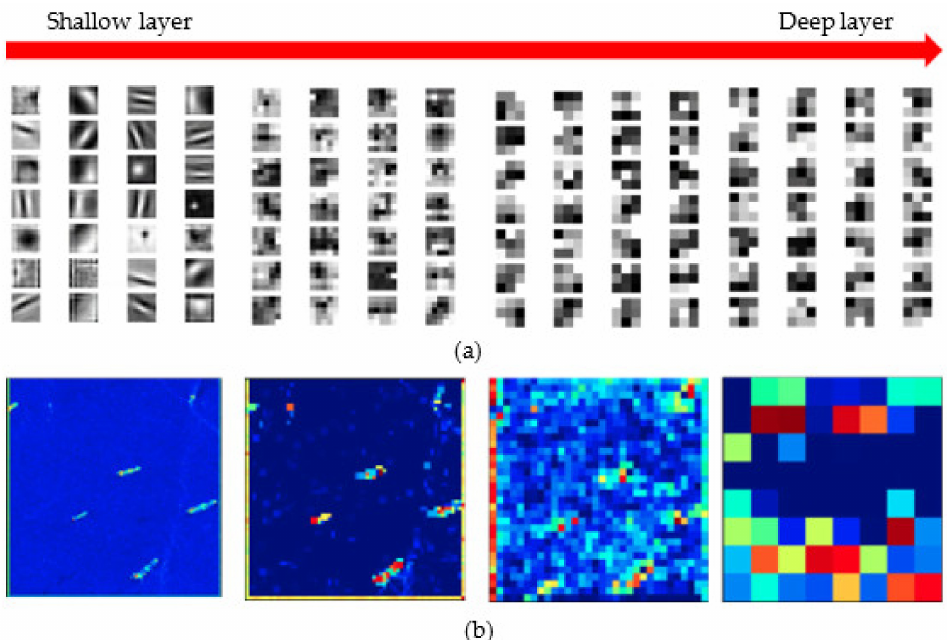
Figure 3. The visualization of feature maps of SAR images. ( a ) The visualization of feature maps extracted by filters from the backbone network of FPN. The shallow layers include more detailed information such as edges, circles, spots, and so on, while the information shown in the deep layers is more abstract. ( b ) Visualization of the feature maps of small ships from shallow layers to deep layers. The number of pixels of small ships decreases with the sizes of the feature maps.